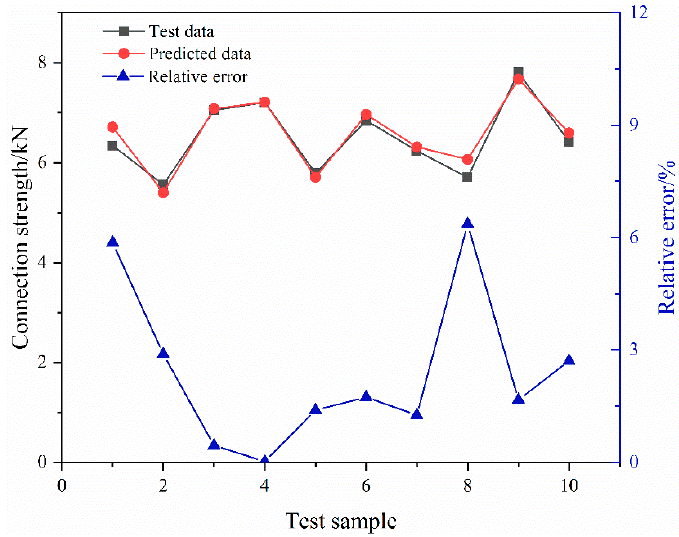
Figure 19. Comparison of predicted output and expected output.